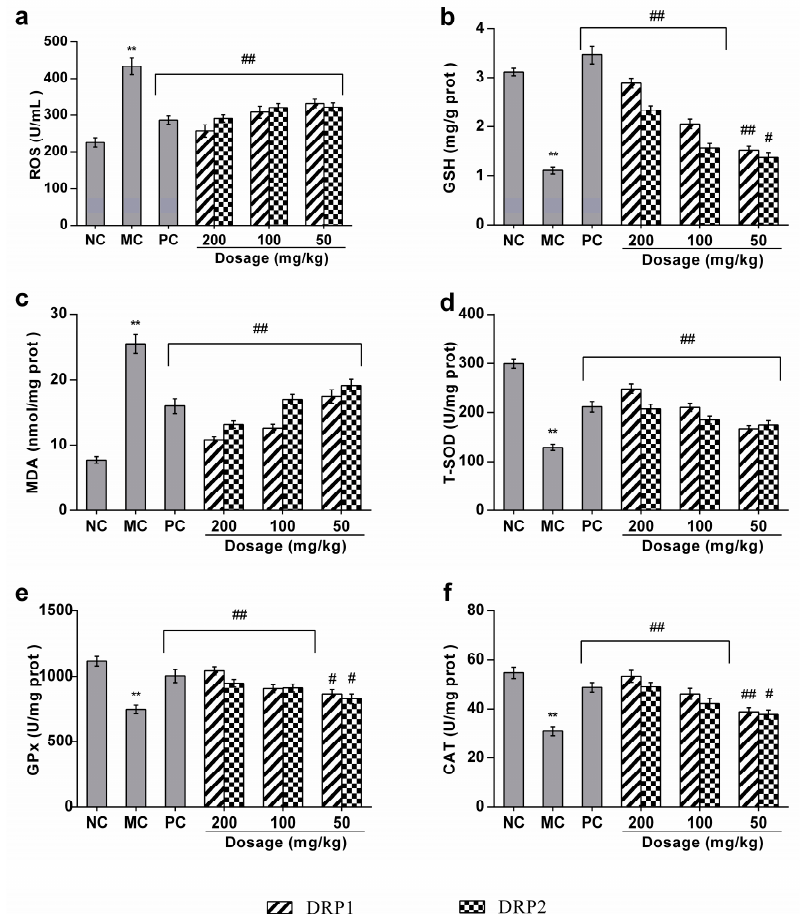
Figure 7. Effects of DRP1 and DRP2 on liver ROS, GSH, MDA, T-SOD, GPx and CAT levels. ( a ), ROS